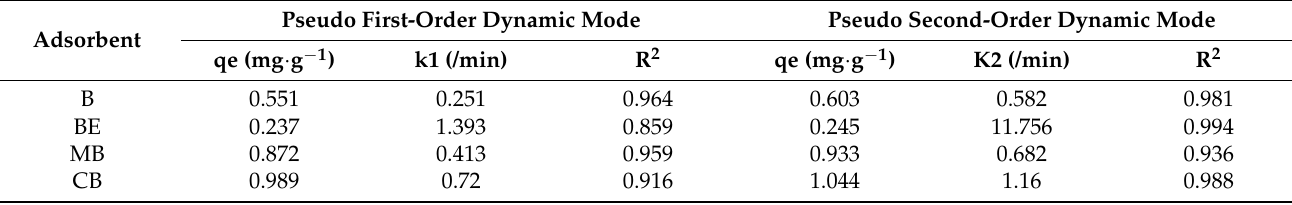
Figure 3. The sorption kinetics ( a ) and isothermal adsorption ( b ) of mercury onto the adsorbent. The thermodynamic adsorption of mercury by CB ( c ). The adsorption thermodynamics model of Hg 2+ on CB was a linear regression ( d ). Effect of initial pH on the adsorption of Hg 2+ onto the adsorbent ( e ). Table 2. The kinetic model parameters of Hg 2+ on the